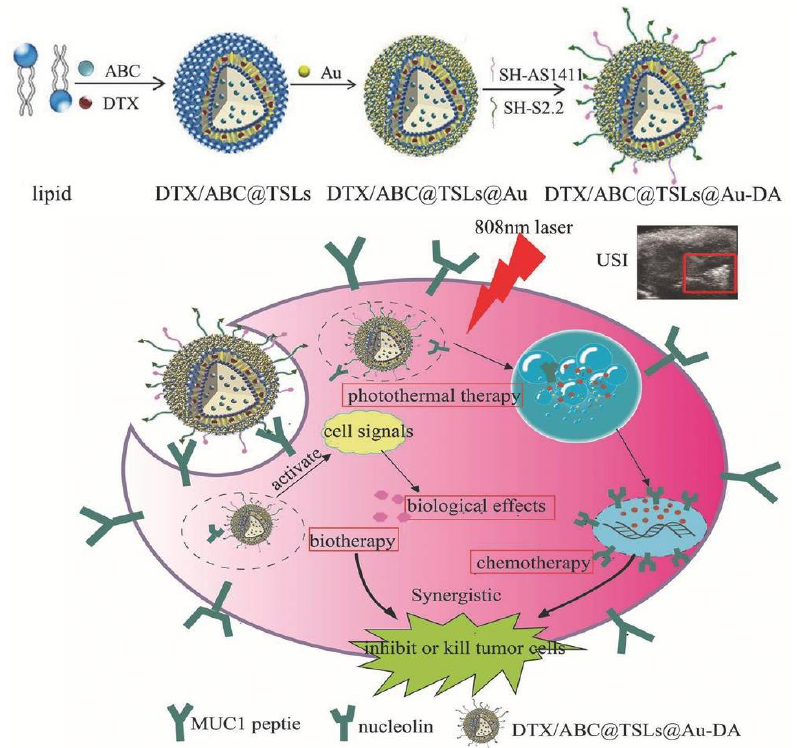
Figure 13. Schematic representation of a near-infrared photo-thermal responsive dual aptamers- targeted docetaxel-containing nano-particles. In this system, docetaxel and NH 4 HCO 3 were loaded in liposomes. The resulting liposomes were subsequently coated with gold that produce heat under 808 nm laser irradiation to induce nano-particles’ decomposition. through thermal activation, the NH 4 HCO 3 containing thermosensitive liposomes generate CO 2 bubbles and the acidic environment at the tumor region that promote bubbles generation. The thermosensitive liposomes were then functionalized with nucleolin and Mucin1 peptide aptamers, the AS1411 G4 and S2.2 sequences, respectively, for a specific internalization by MCF-7 cells. Copyright (2017) Wiley. Used